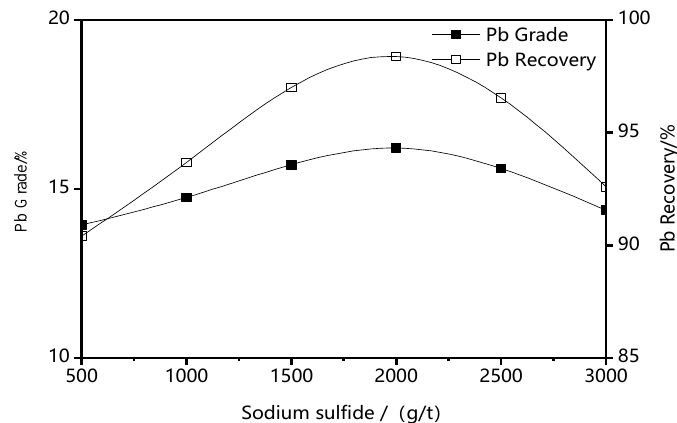
Figure 3. The influence of Na 2 S dosage on Pb rougher flotation.